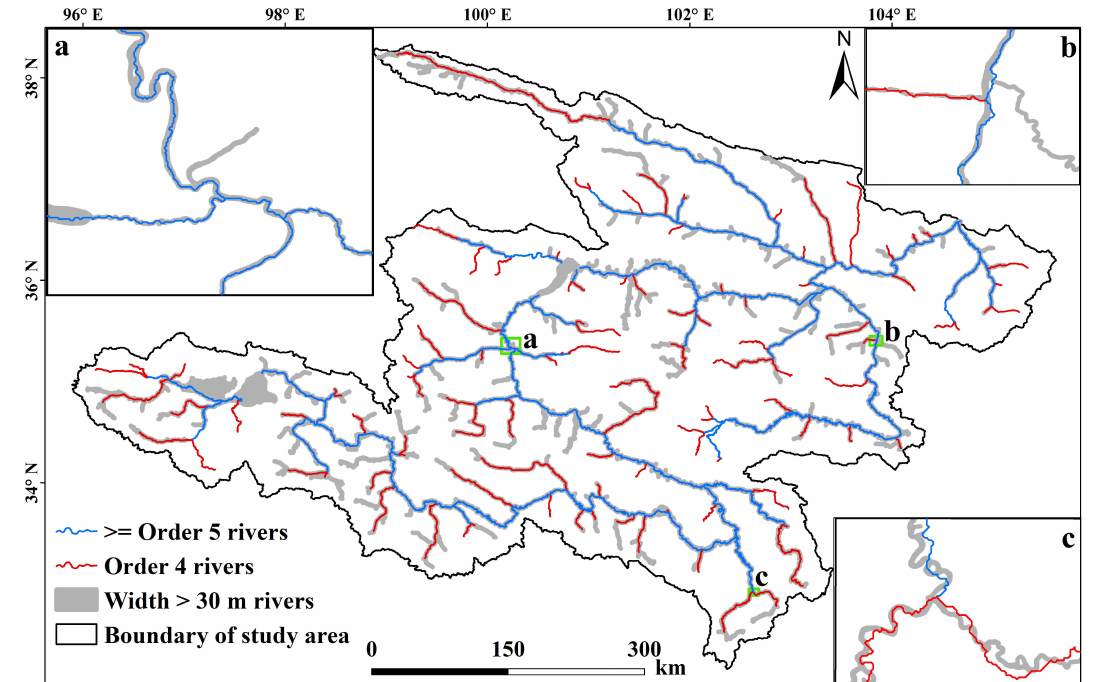
Figure 8. Comparison of the extraction results of connected rivers (width > 30 m) and river networks from the SRTM 90 m DEM. Width > 30 m rivers are the extraction results of connected rivers from Sentinel-2 images in the study area. ≥ Order 5 rivers are order 5–7 river networks from the SRTM 90 m DEM, Order 4 rivers are order 4 river networks from the SRTM 90 m DEM.